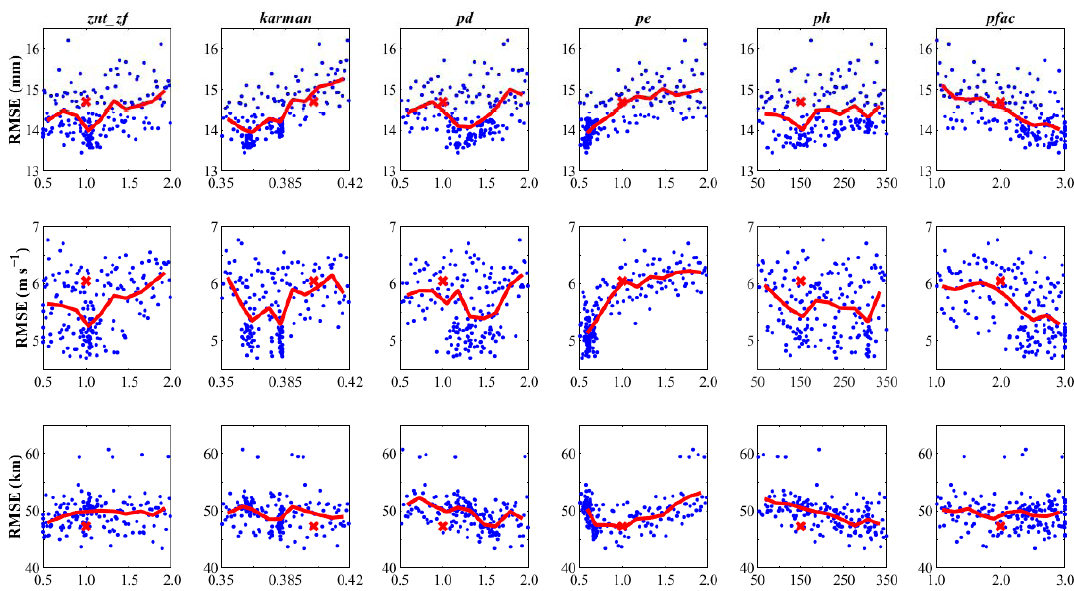
Figure 17. Responses of model performances to six sensitive parameters based on the 178 model simulations from optimization experiment. Red curve represents an average of the simulation errors at each bin. The simulation error with default parameters is marked as a red cross. Each line demonstrates one variable, and the lines from top to bottom are precipitation, 10-m wind, and track respectively.